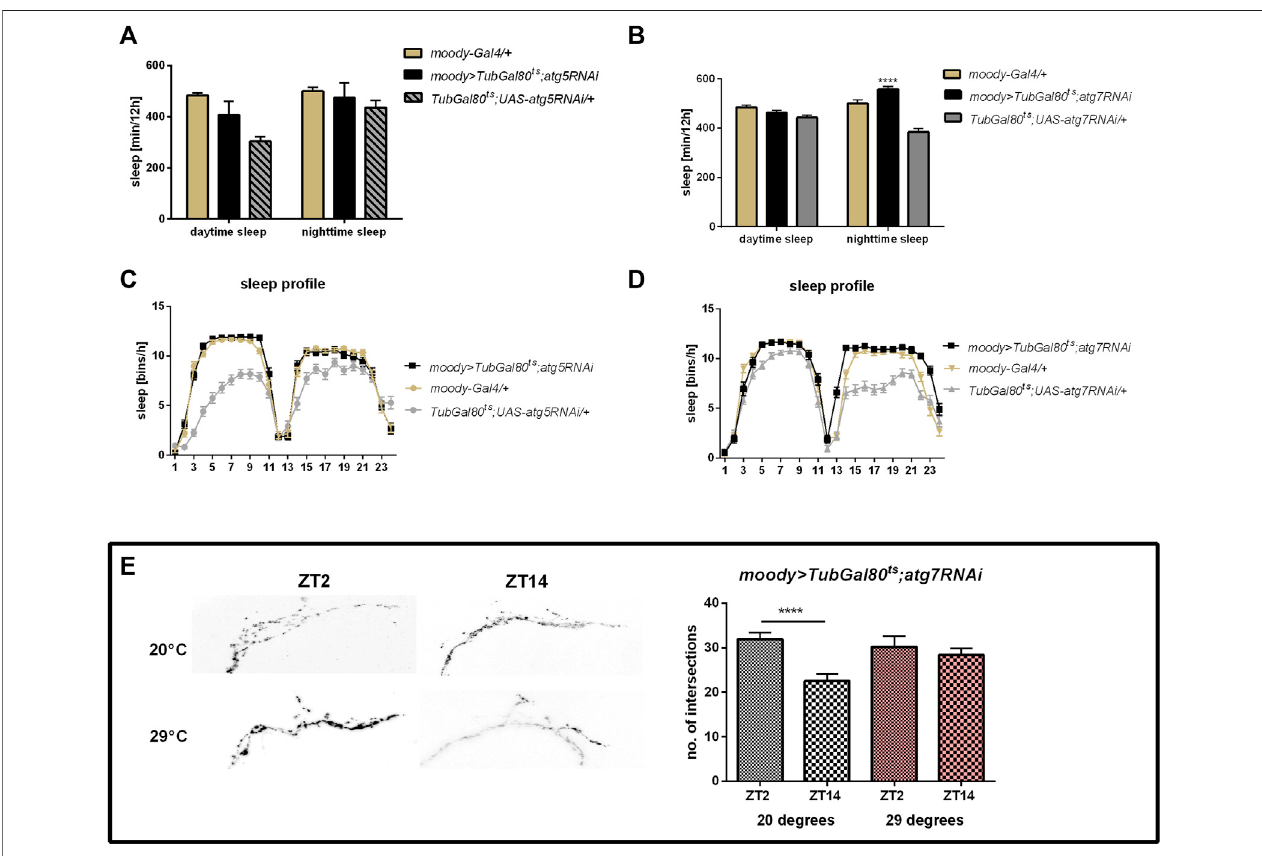
FIGURE 4 | Effect of autophagy disruption in subperineurial and pseudocartridge glia ( moody marker) Adult speci fi c atg5 silencing did not affect sleep time regulates (A,C) , however atg7RNAi expression increased sleep level during the night (B,D) and detained daily changes in sLNv terminal arborisation complexity (E) . Statistically signi fi cant changes marked as asterisks *** p ≤ 0.001, **** p ≤